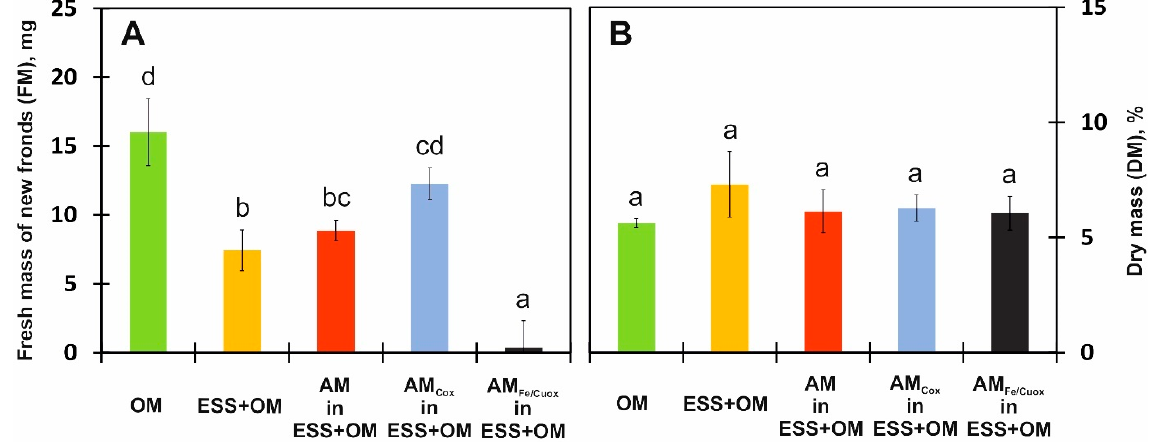
Figure 6. Fresh mass (FM) ( A ) of new fronds, dry matter content (DM) ( B ) of L. minor exposed to OM, ESS+OM; AM in ESS+OM; AM Cox in ESS+OM; AM Fe/Cuox in ESS+OM. The data points represent the mean ± SD, n = 6. Values are significantly different from the control at p < 0.01 (a–d).